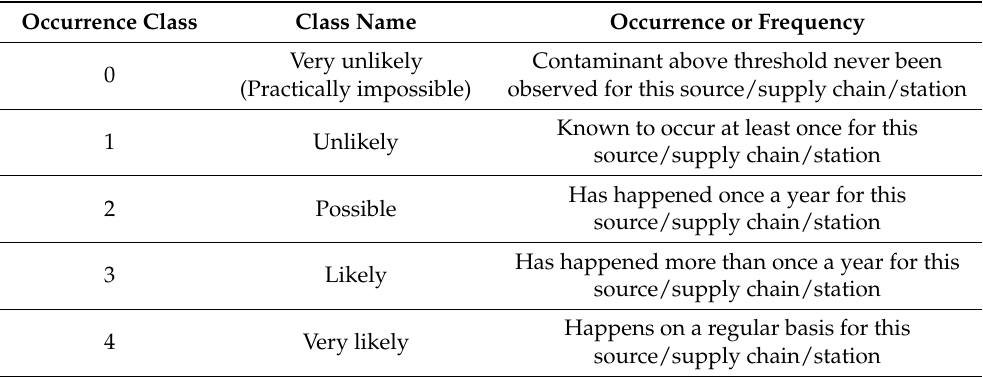
Table 2. Definition of the occurrence or frequency for the probability of contaminant occurrence. Occurrence